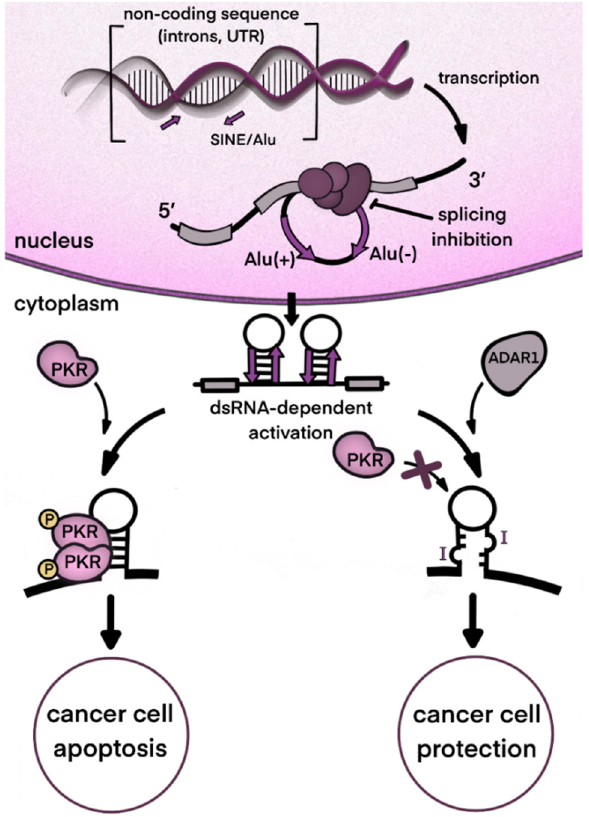
Figure 4. Potential synergy between inhibition of ADAR1 and splicing in cancer therapy. One of the proposed mechanisms of spliceosome-targeted therapies is the accumulation of dsRNA in the cytoplasm. Excess dsRNA activates innate immunity and can lead to PKR-dependent apoptosis. ADAR1 activity destabilizes dsRNA structures and prevents excessive PKR activation, protecting tumor cells and reducing the effectiveness of therapy. ADAR inhibition can significantly enhance the effectiveness of therapy by increasing the amount of dsRNA in the cell and, consequently, enhancing RKR-dependent